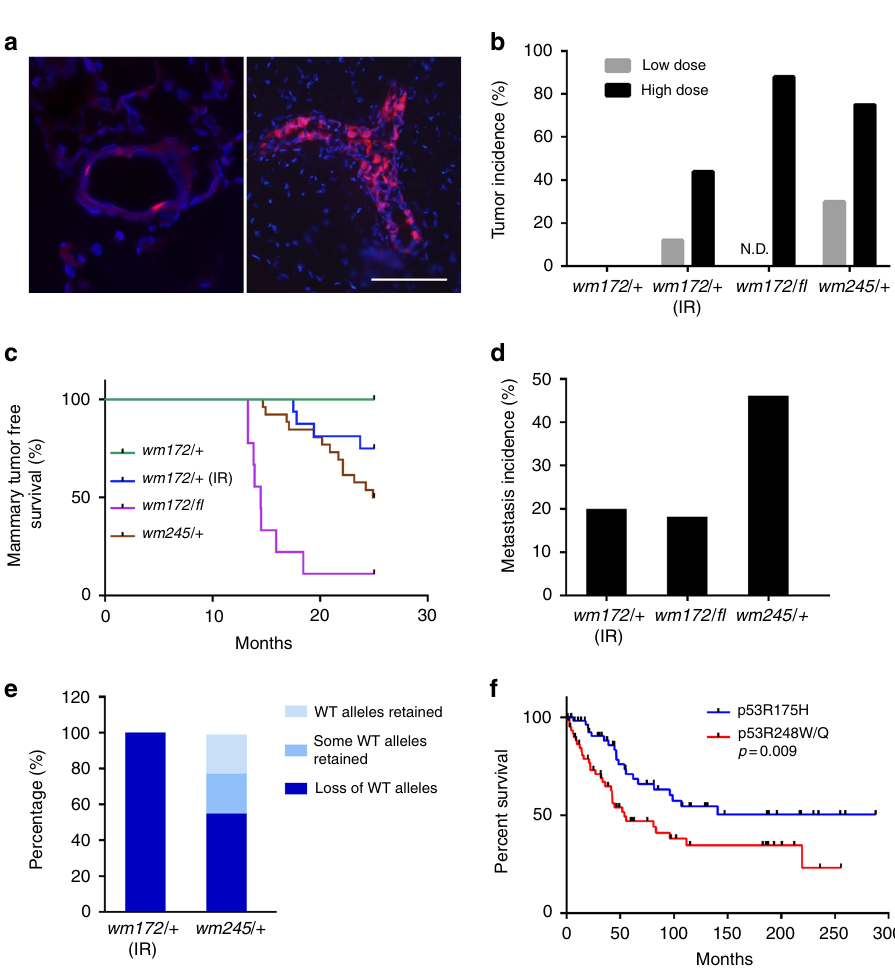
Fig. 2 Somatic Trp53R172H and Trp53R245W mutations in mouse mammary epithelium drive tumorigenesis. a Representative pictures of mouse mammary glands from Rosa26-LSL-tdTomato mice after Ad-Cre injection in mammary ducts. Two doses of Ad-Cre were deployed for mammary intraductal injection,